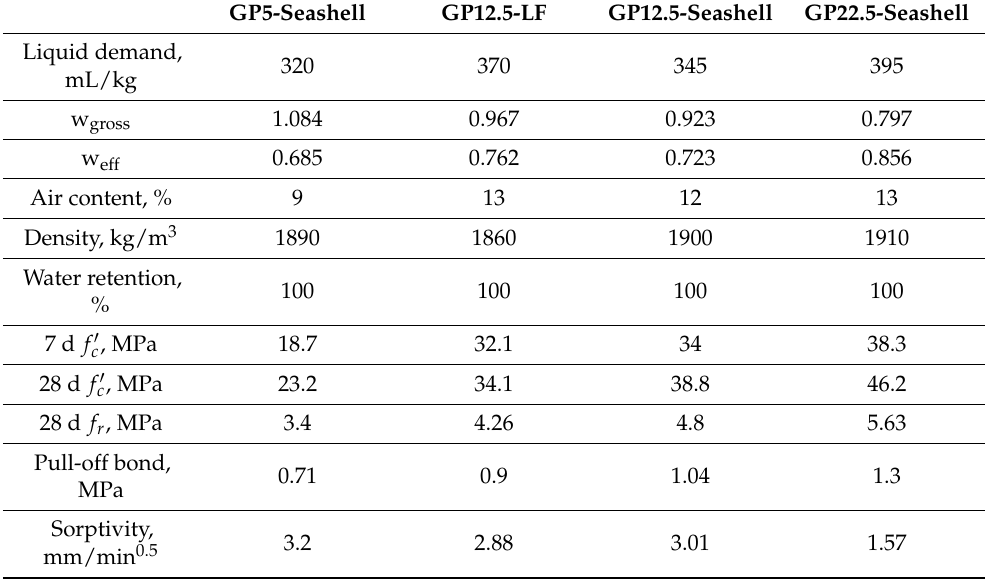
Table 4. Physical and mechanical properties for mortars containing GP